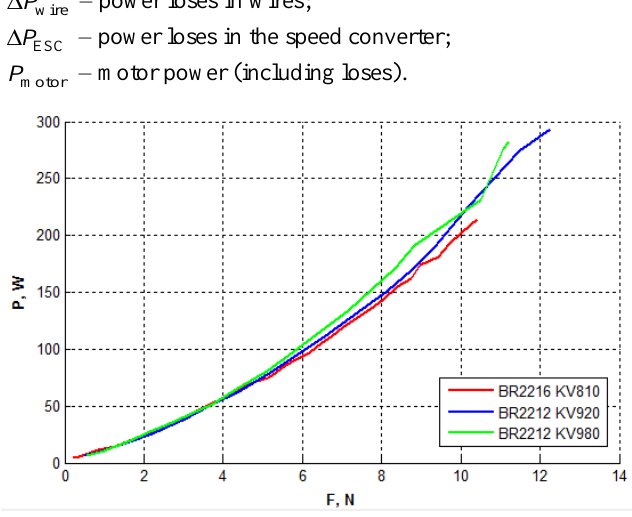
Fig. 7. Power-force curves of three motors.